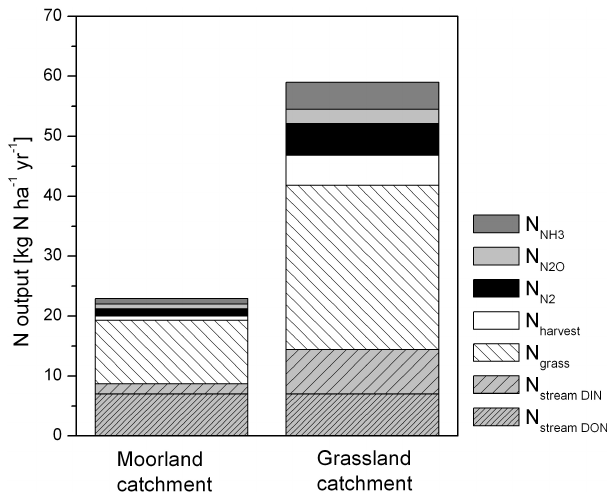
Fig. 4. N outputs (kgNha − 1 yr − 1 ) to the Moorland (left) and the Grassland catchment (right). Stream TDN export fluxes (N stream ) are split into the dissolved inorganic flux (N stream DIN = fluxes of NH + and NO − ) and the dissolved organic flux (N stream DON ). 4 3